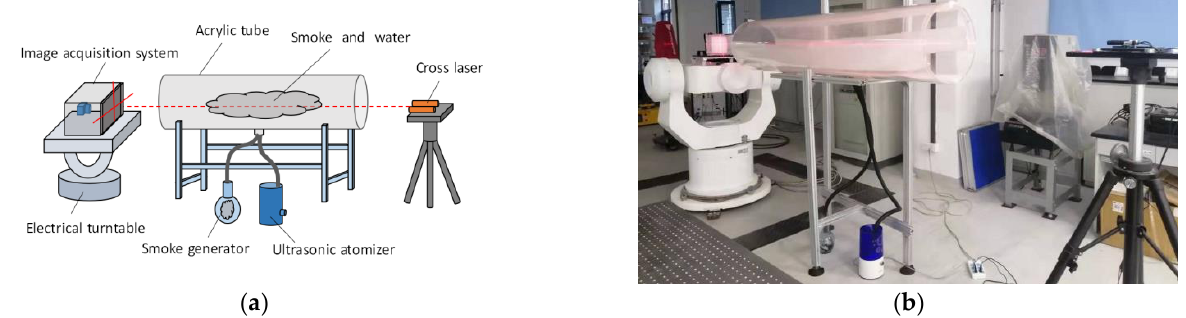
Figure 25. (a) Experimental schematic diagram. (b) Experiment procedure picture under smoke and water mist environ- Figure 25. ( a ) Experimental schematic diagram. ( b ) Experiment procedure picture under smoke and water mist environment.